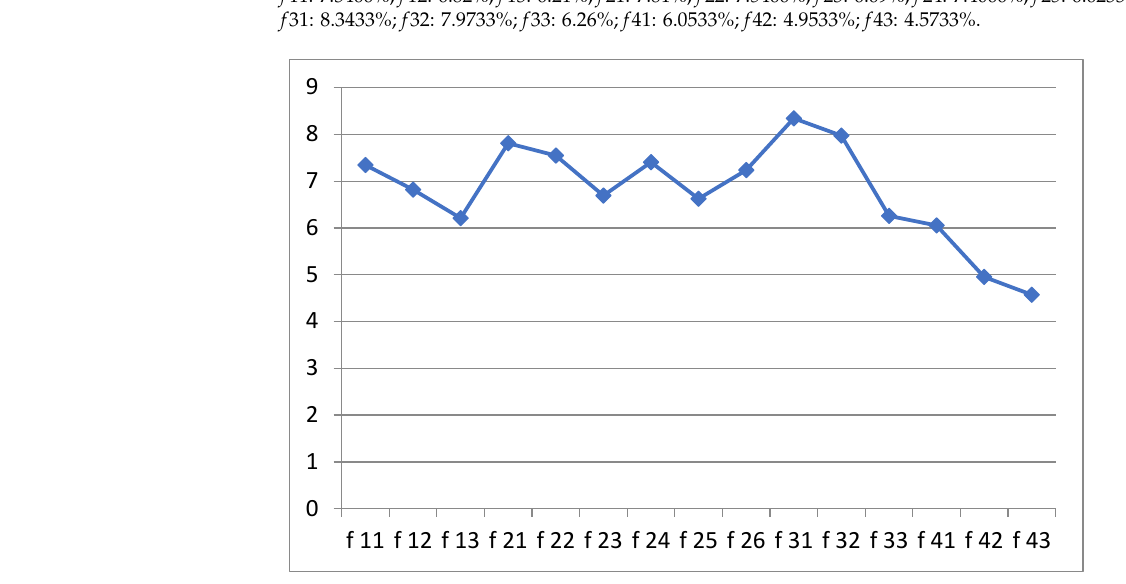
Figure 5. Influence level of FAHP model criterion.